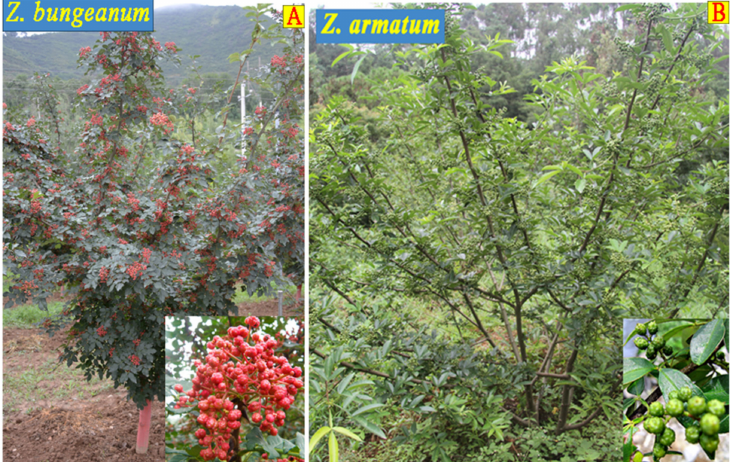
Figure 1. Morphological characteristics of the two Chinese pepper species. ( A ) The leaflets of Z. bungeanum are opposite, ovate orbicular or oblongovate and crenulate, and the red pericarp is used as essential cuisine spices. ( B ) Z. armatum is characterized by the presence of green pericarp used in cuisine, odd pinnate compound leaves with winged